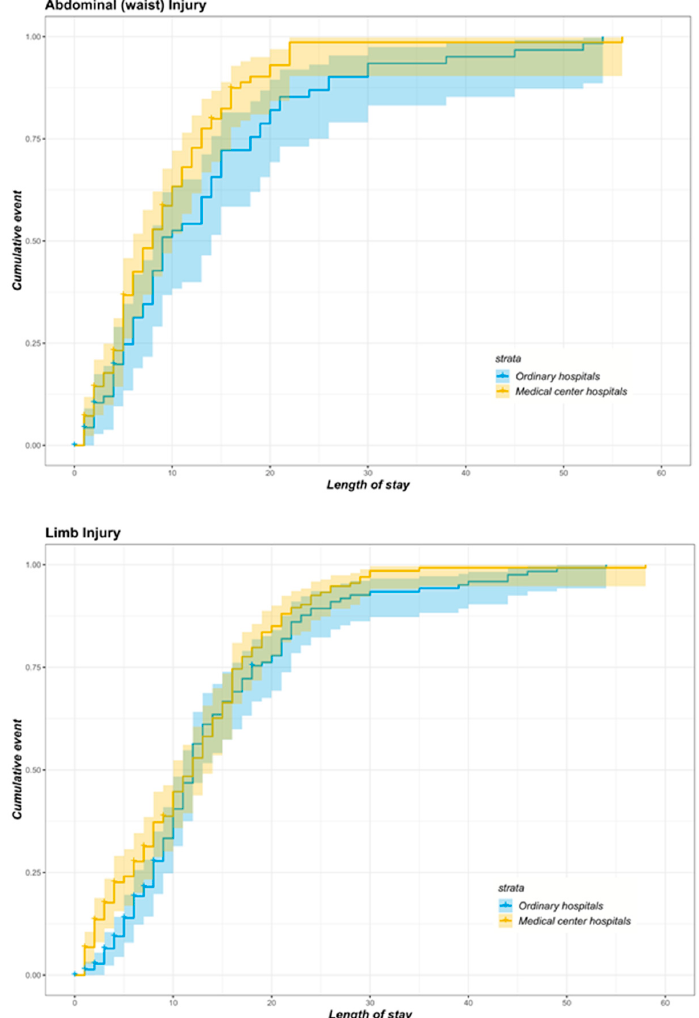
Figure 5. Kaplan–Meier survival curves of matched head injury, chest (back) injury, abdominal (waist), and limb injury patients transported by EMS in two groups.